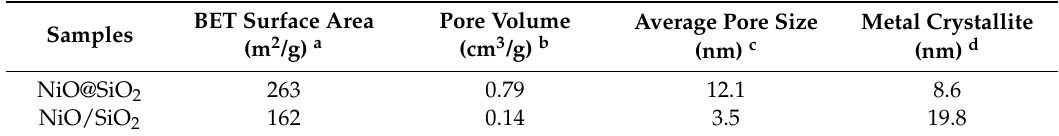
Table 1. Characteristics of NiO@SiO 2 and NiO/SiO 2 samples determined by N 2 sorption and XRD. Samples